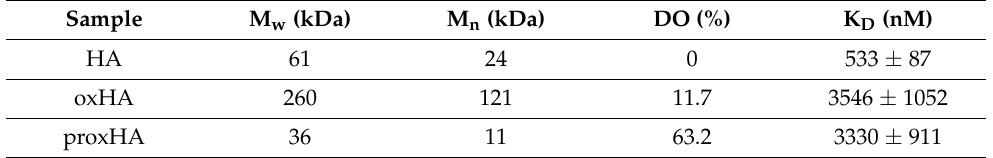
Values of dissociation constant of unmodified HA, NaIO 4 oxidized (oxHA), and TEMPO/TCC oxidized HA (proxHA) with different degrees of oxidation